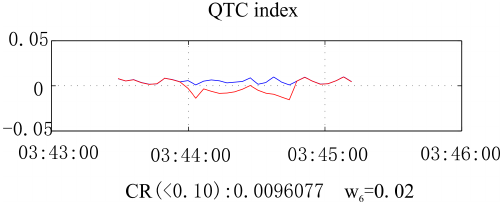
Figure 11. QTC index of original data (blue) and simulated data of waveform repetition variation